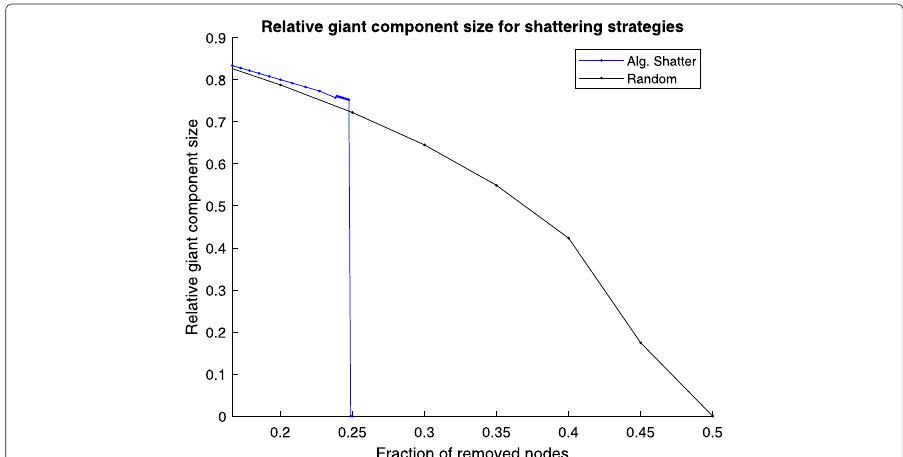
Fig. 2 Comparison of the performance of Algorithm Shatter vs Random Removal (which, in this case is also equivalent to Attack by Degree), for a random 3-regular graph with 10 5